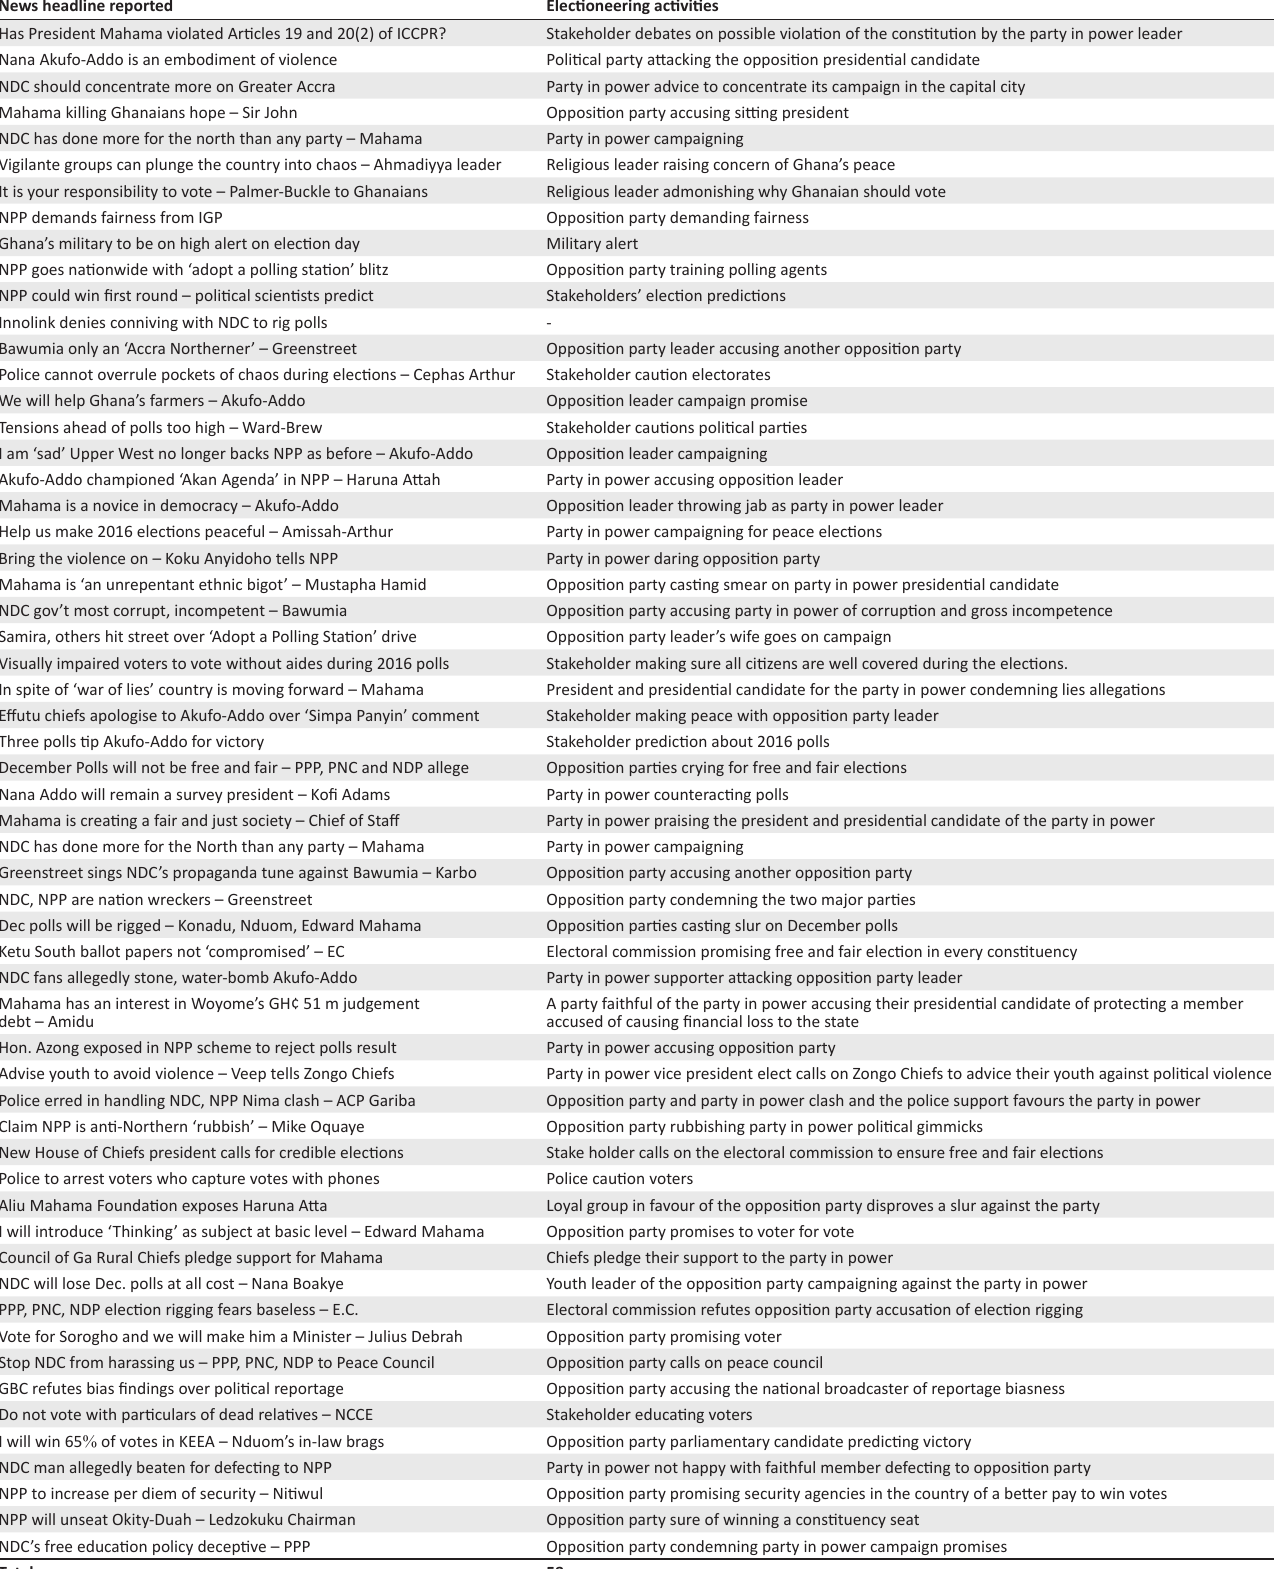
TABLE 1-A1: Electioneering activities data on 24 November